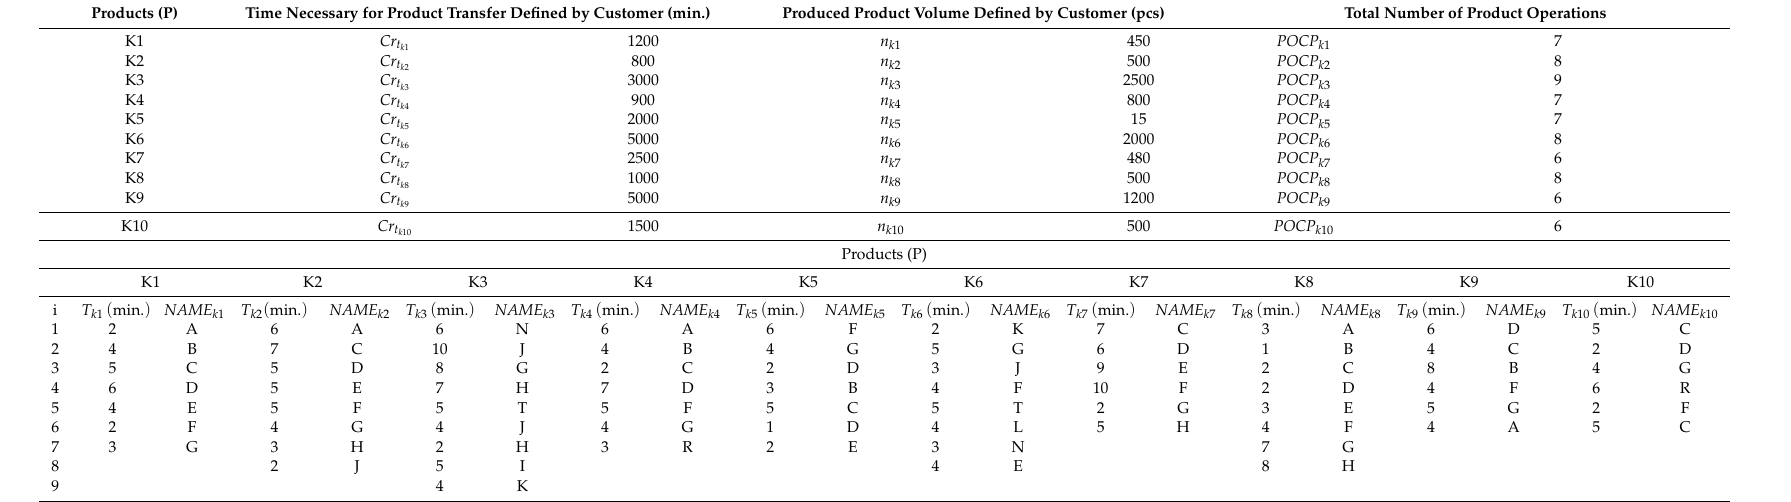
Table 1. The input values for